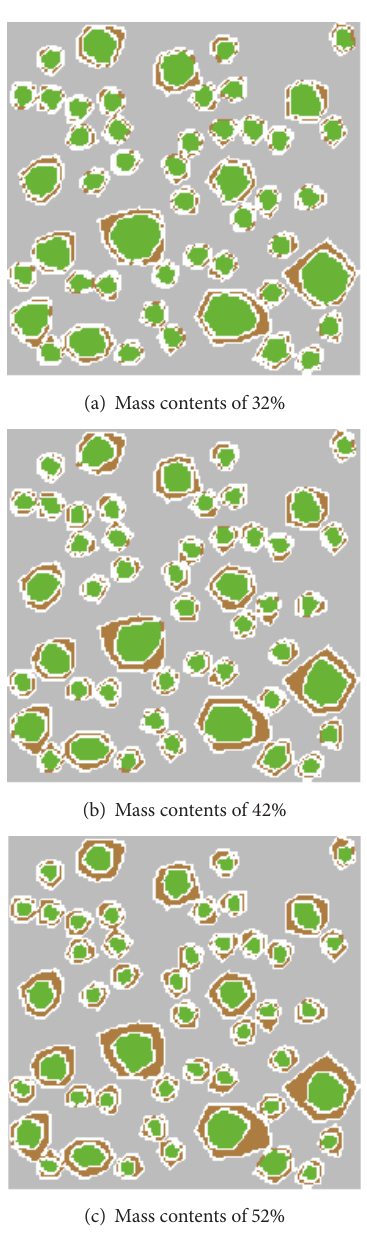
Figure 9: RAC models with different mass contents of old